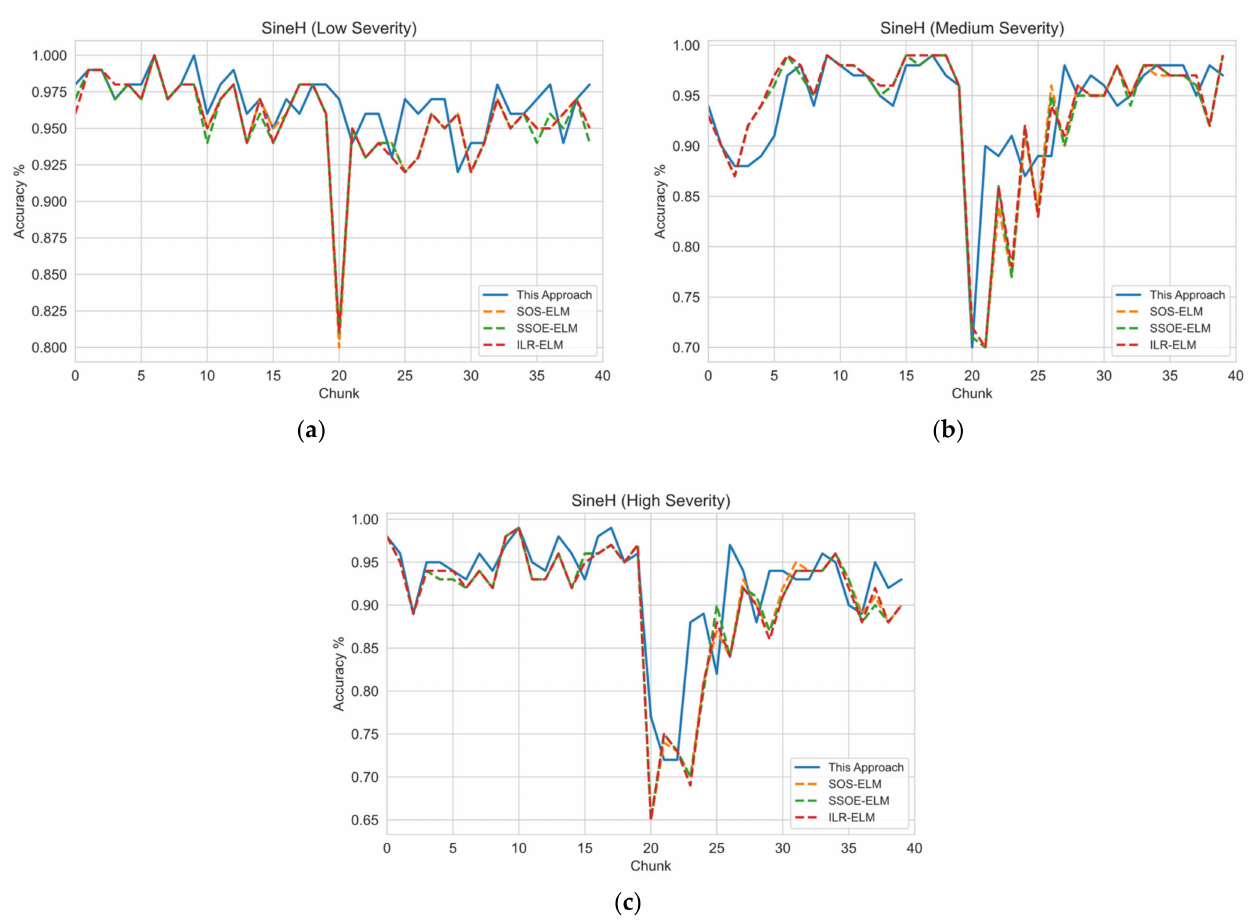
Figure 5. SineH dataset experiment on variable concept drift severity. ( a ) Performance on low severity dataset. ( b ) Performance on medium severity dataset. ( c ) The performance on high severity